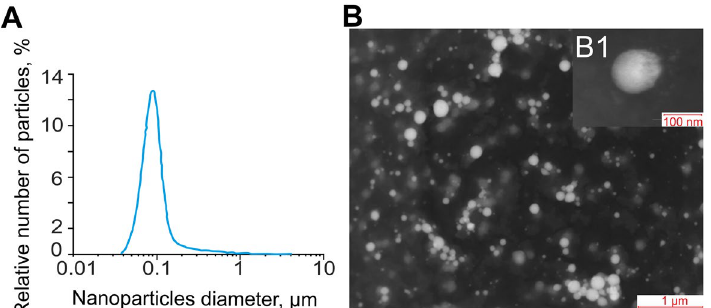
Figure 1. Size and morphology of selenium nanoparticles obtained by laser ablation. ( A ) Selenium nanoparticle size distribution. Data obtained using an analytical disk centrifuge and confirmed by DLS. ( B ) TEM micrograph of selenium nanoparticles. Scale bar—1 μm. ( B1 ) TEM micrograph of single selenium